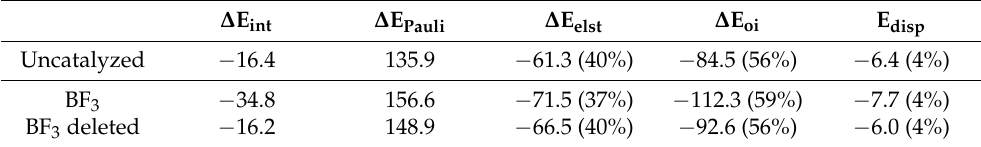
Table 4. EDA analysis of the transition state for the uncatalyzed and BF 3 -catalyzed reactions between benzaldehyde and 2,3-dimethyl 1,3-butadiene, the latter in the presence and absence of the catalyst. All values are given in kcal mol − 1 . The values in brackets represent the relative contribution of the given energies to the stabilizing part of the total interaction energy. ∆ E ∆ E ∆ E ∆ E int oi E disp Pauli elst Uncatalyzed −